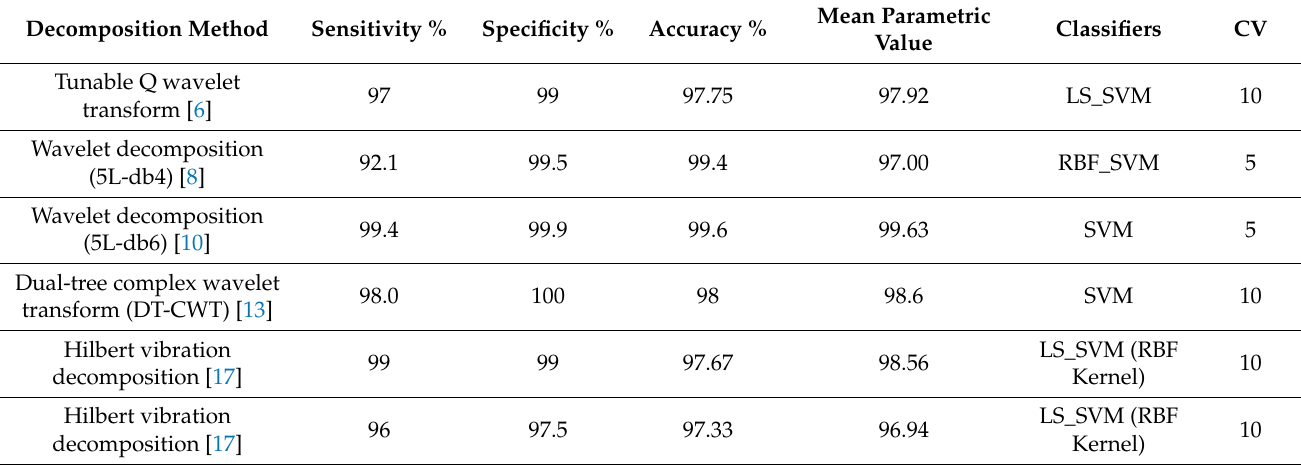
Table 5. Performance comparison of seizure detection method using SVM-based